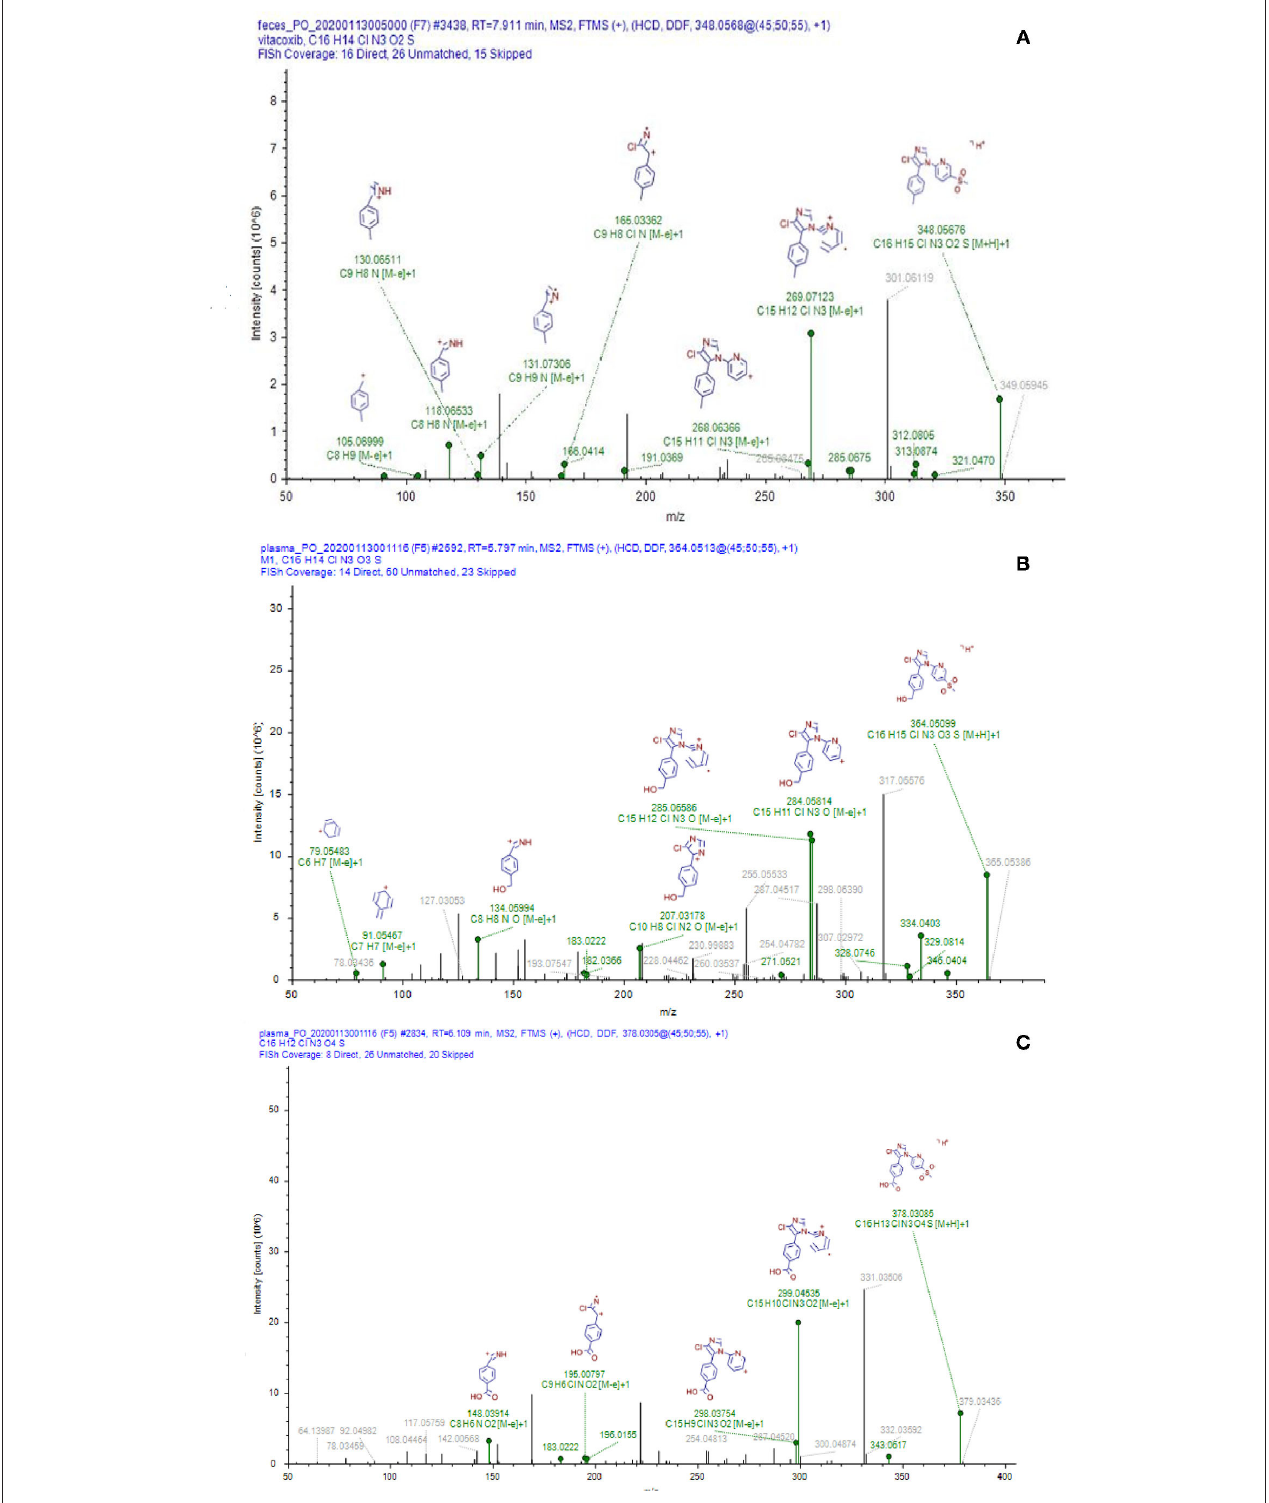
FIGURE 6 | Representative daughter-ion mass spectrum and chemical structure of vitacoxib (A) , M1 (B) and M2 (C) .